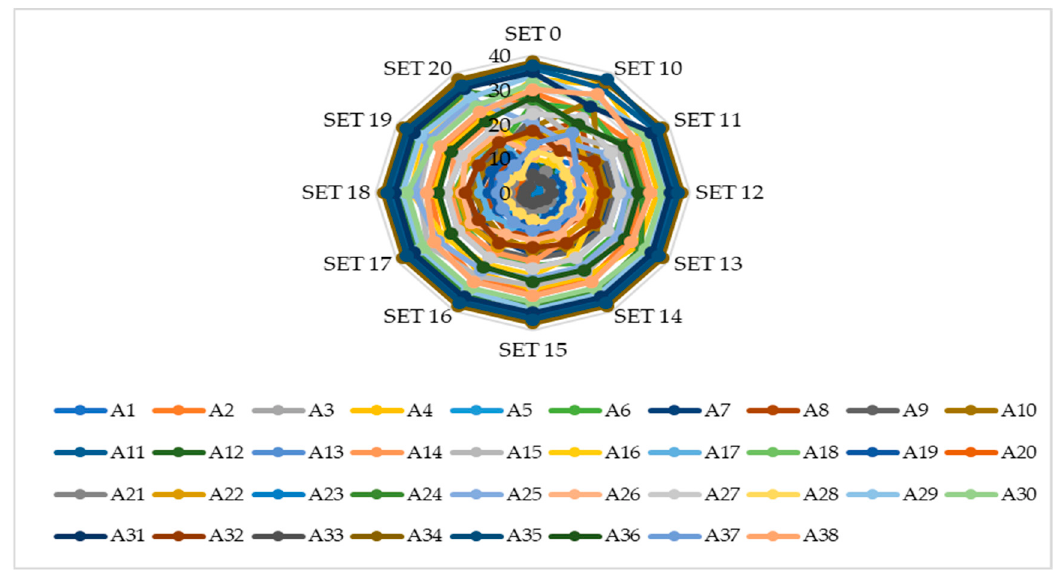
Figure 3. Comparison of initial results with the second group of scenarios, i.e., scenarios S11–S20.